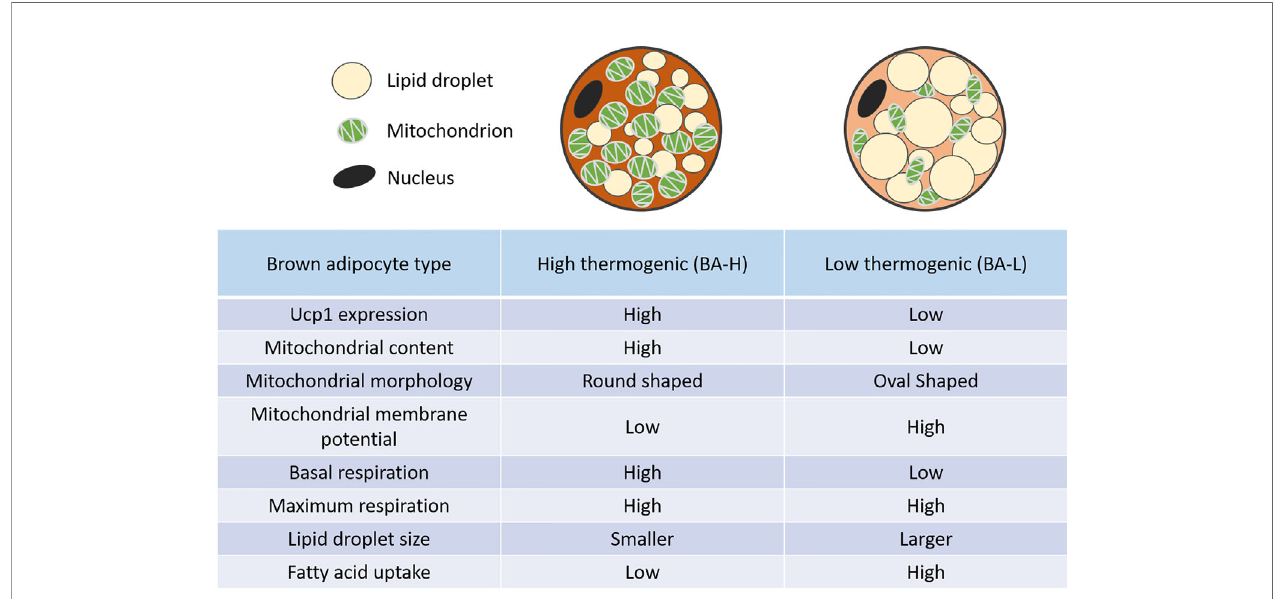
FIGURE 1 | Distinct features of high and low thermogenic adipocytes. Relative to the high thermogenic brown adipocytes (BA-H), the low thermogenic brown adipocytes (BA-L) have lower UCP1 expression, low mitochondrial content, high mitochondrial membrane potential, and distinct mitochondrial morphology. These cells have a lower basal respiration rate, but a similar maximum respiration rate. They also have larger lipid droplets, and a higher fatty acid uptake rate